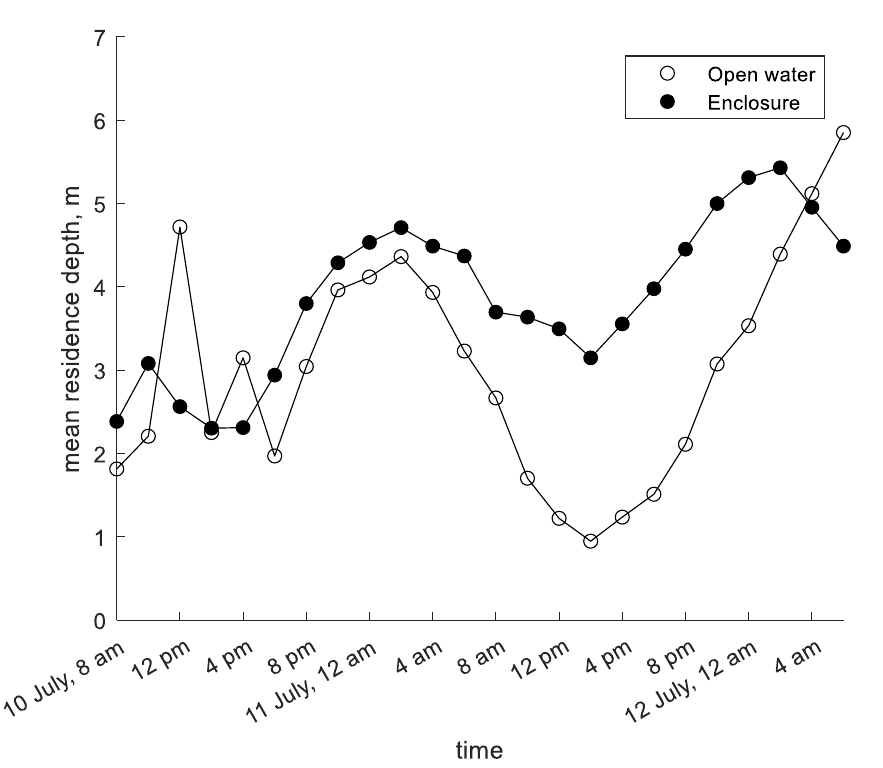
Figure 3. Mean residence depth (MRD) calculated from chlorophyll a profiles measured in Shennong Stream open water and enclosure sites; data extracted from Cui et al. [12].